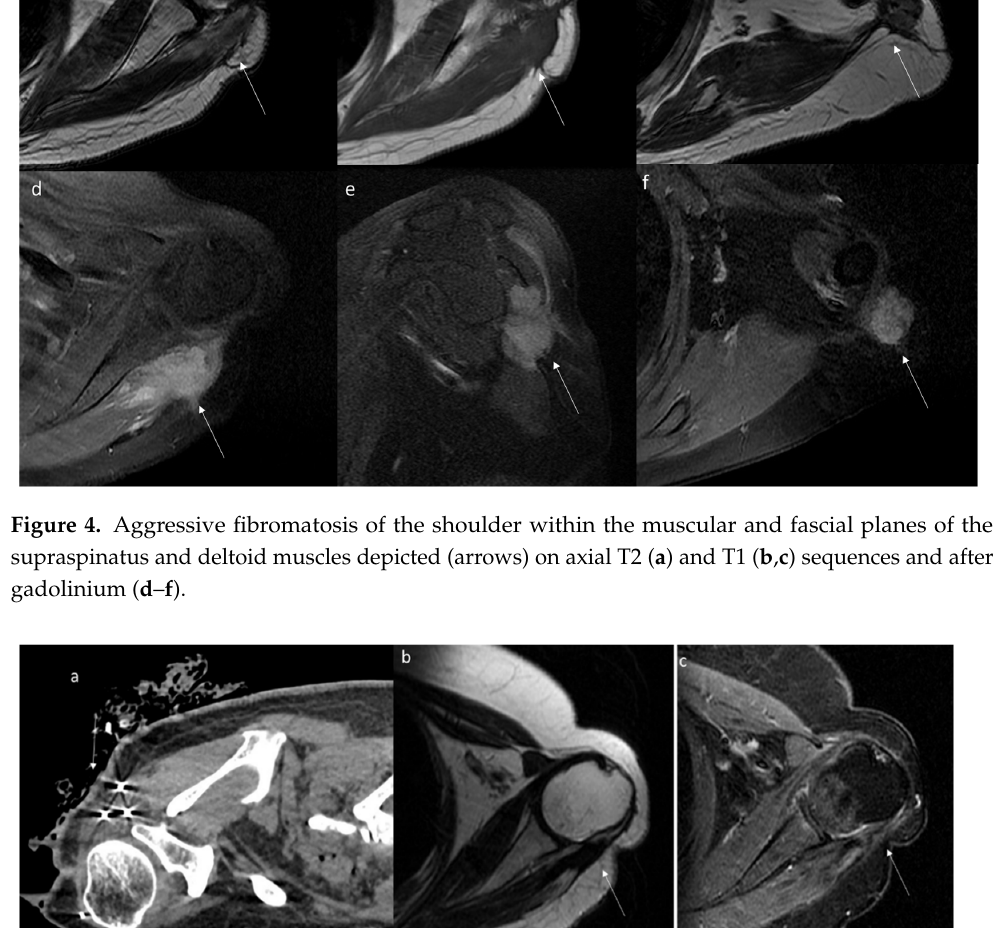
Figure 6. Desmoid of the anterior abdominal wall. MRI axial slices in T2 ( a ), T1 ( b ), and gadolinium- enhanced T1 ( c ) sequences. A nodular lesion is evident within the muscular and fascial planes of the internal and external oblique muscles (arrow) . Beyond information on morphology, several MRI sequences can be used to obtain functional, ultrastructural information on tissue and deepen the diagnosis. Using DWI imaging, the DWI signal and the ADC values reflect the cellularity of the tissues, so even if there are no normal cutoff values, DWI can characterize the biological activity of the tissues [153–160]. In the study of musculoskeletal soft tissue tumors, this means that, as a general rule, benign tumors with a low degree of biological activity will have a loss of ADC signal as the b values increase, while malignant tumors (in which the water has greater restriction in movement) will show high intensity at high b values [161,162]. The mean ADC of DTs was found to be significantly higher than that of malig- nant soft tissue tumors without overlap in the minimum ADC values [163]. DWI has also proved very useful in the assessment of treatment response [66,96]. Similarly, the evalua- tion of enhancement patterns can be challenging, as both granulation and scar tissues